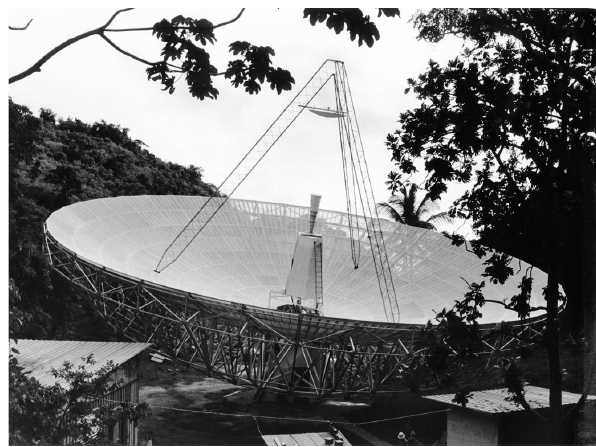
Figure 10. The Higuillales (Los Ca˜nos) 30.5m parabolic dish used by Woodman (1980a) for S-band studies of stratospheric turbu- lence. Photo courtesy of Cornell University and Arecibo Observa-